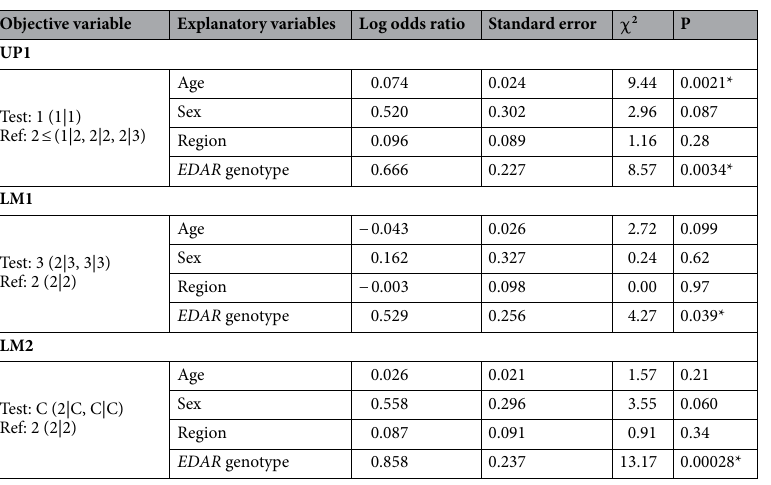
Table 2. Logistic regression analyses on the root shape of UP1s, LM1s, and LM2s. Phenotypes of each tooth are dichotomized into test and ref and the log odds ratio of test to ref is shown. EDAR genotype is represented as VV = 0, VA = 1 and AA = 2, sex as male = 0 and female = 1, and region as the number of grandparents originating from the Ryukyu Islands. *Significant association (P < 0.05).